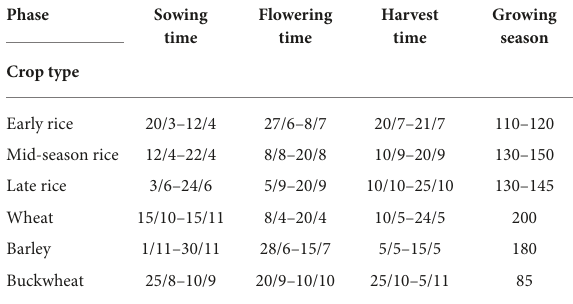
TABLE 4 Contemporary phenological phase of staple crops in Yidu county-level city, Yichang city, Hubei Province. Phase Sowing Flowering Harvest time time